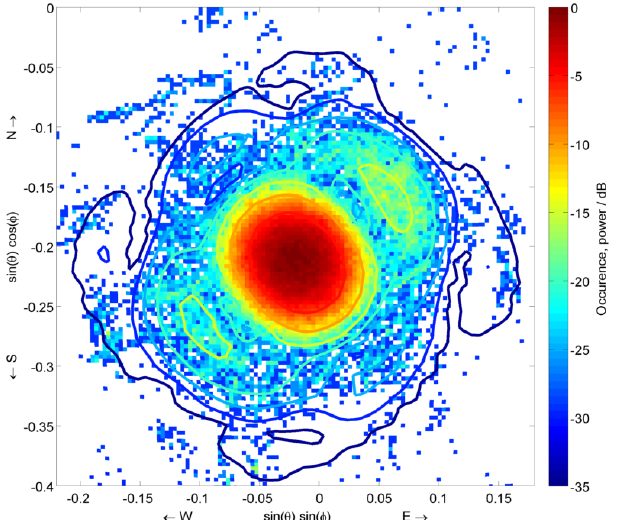
Figure 6. Cross sections through the angular occurrence rate for both beam directions compared to the simulated radiation pattern for the period of 1–8 January 2014. The simulated and estimated beam widths are shown at the bottom.